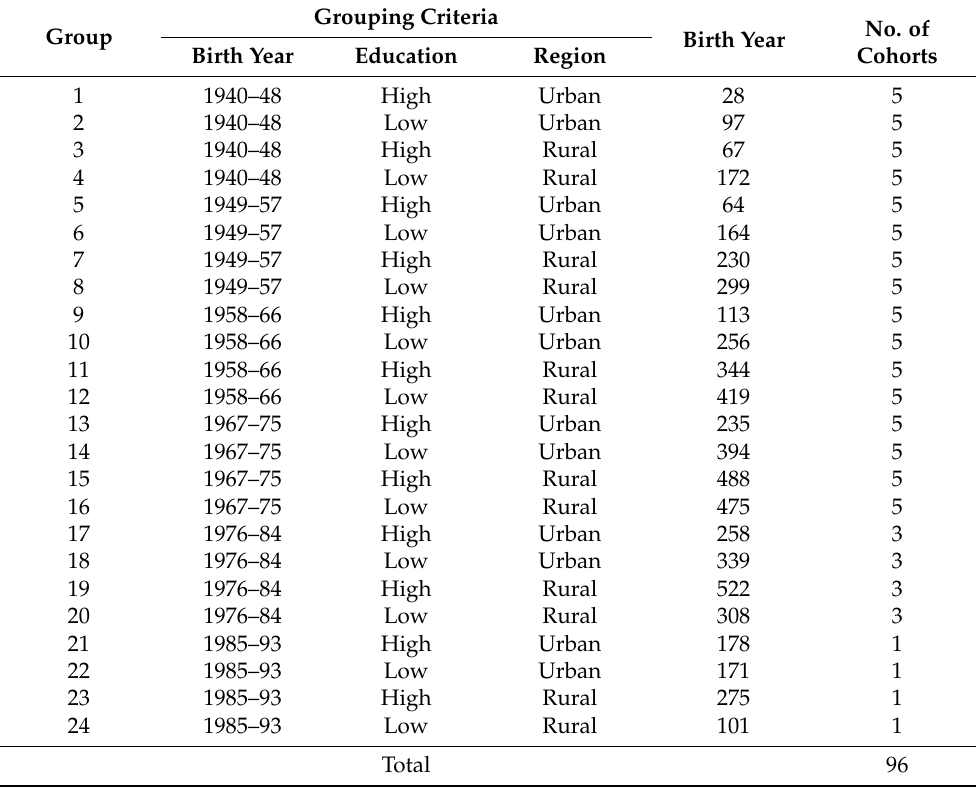
Table A1. Overview of Constructed Groups Based on Birth Year, Education and Region.